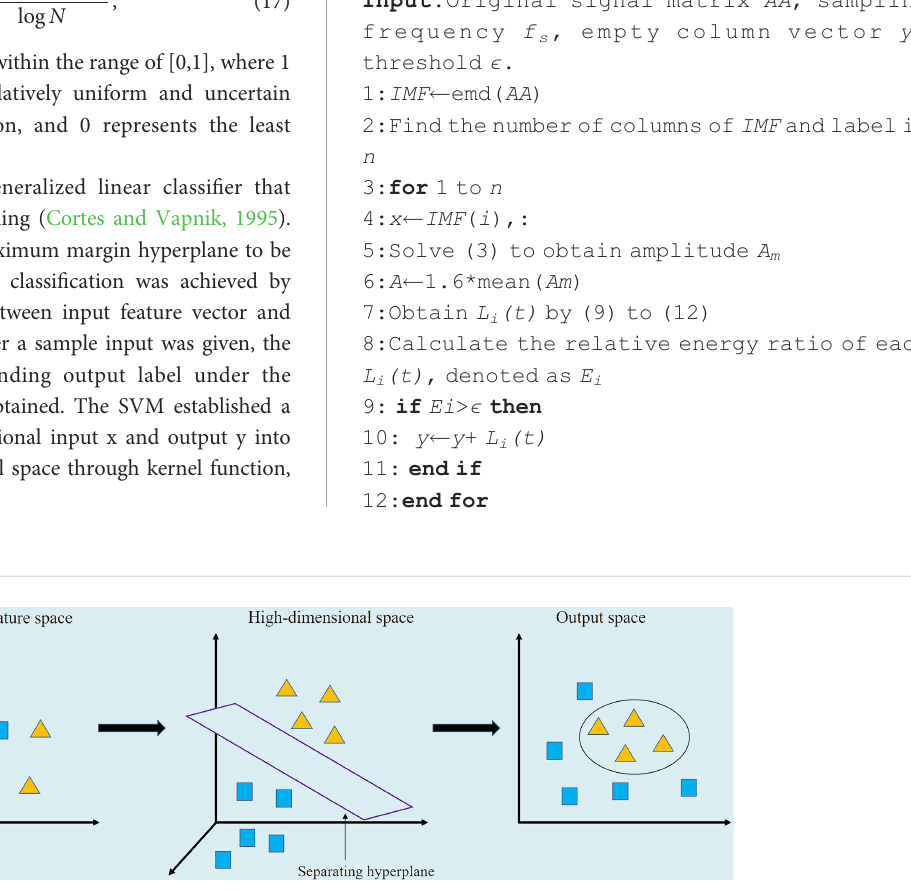
FIGURE 3 Nonlinear SVM schematic